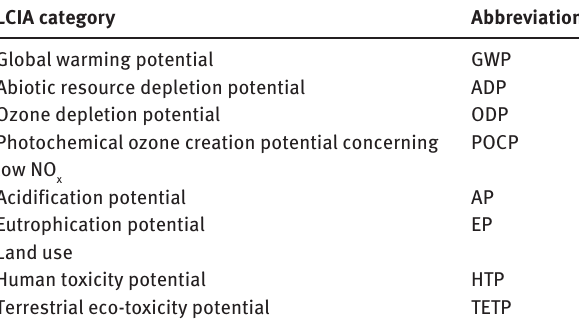
Table 1 Life cycle impact assessment (LCIA) categories [7] used for (S)LCA investigation in case studies A–C.